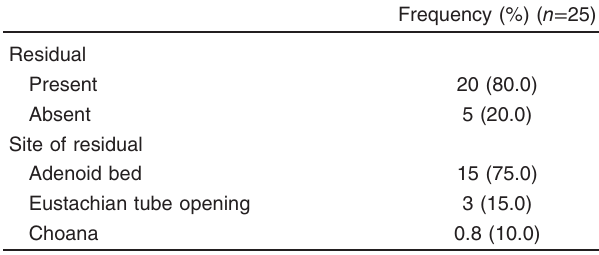
Table 2 Description of residual adenoid tissue in group A only